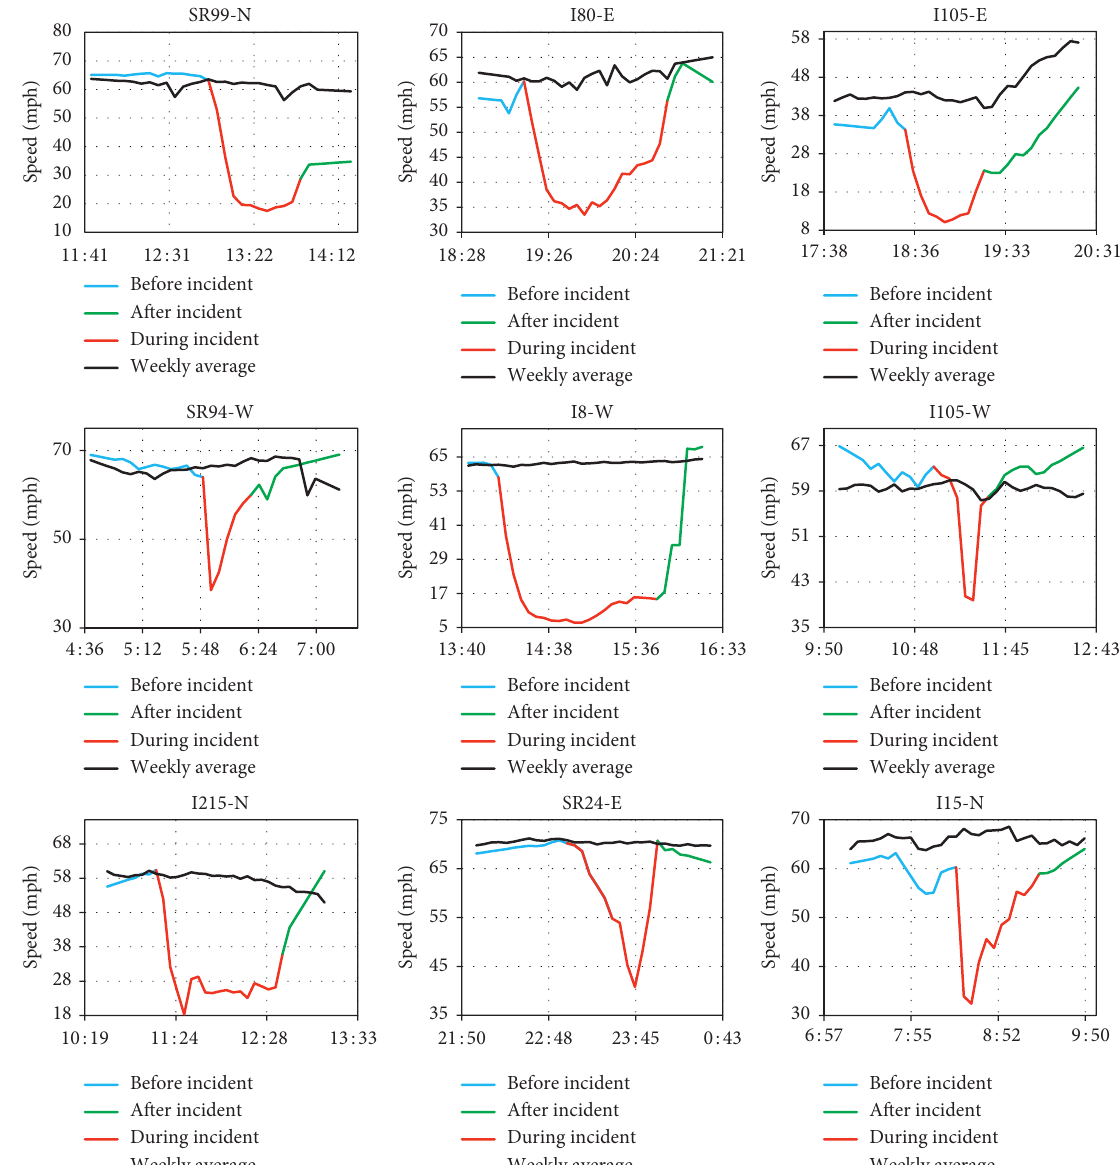
Figure 3: The comparison of pre-incident, during the incident and post-incident speeds with the weekly average